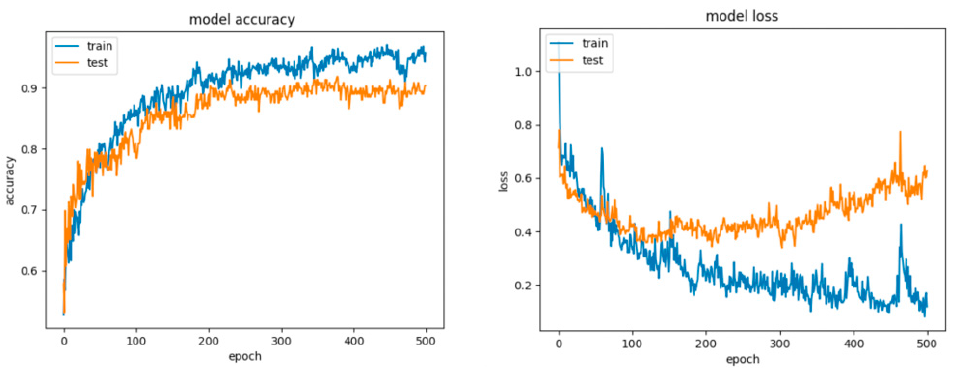
Figure 20. Accuracy and loss for Configuration 3, non-overlapping dataset.